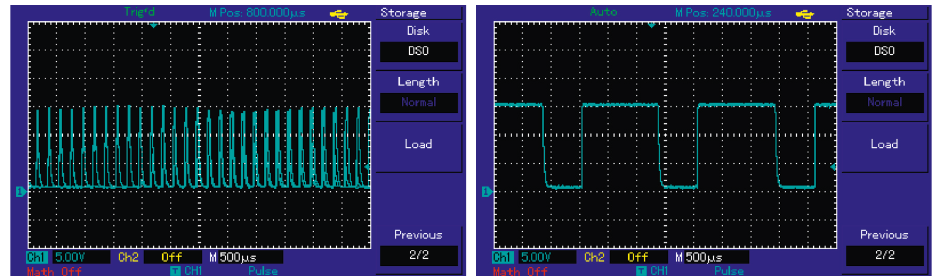
Figure 15: Charging and discharging of the BSC at different frequencies.